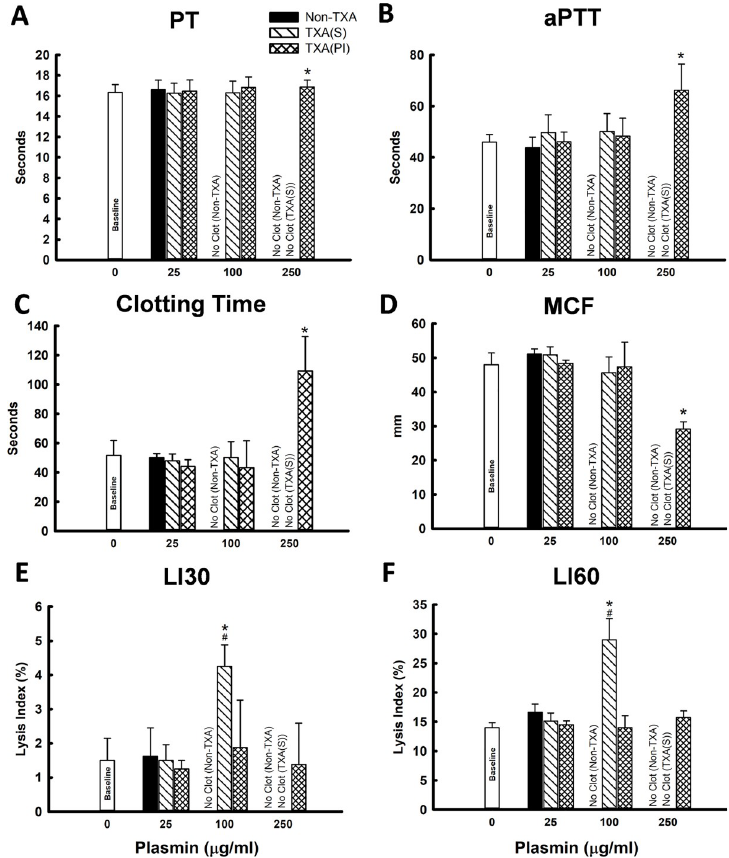
Fig 1. In-vitro assay in human whole blood (n = 4 per group). (A) PT; (B) aPTT; (C) Clotting Time (CT); (D) Maximum Clot Firmness (MCF); (E) Lysis Index at 30min (LI30, the percent reduction in MCF at 30min); (F) Lysis Index at 60min (LI60, the percent reduction in MCF at 60min). Non-TXA: plasmin was added alone when assay started; TXA-S: TXA and plasmin were added simultaneously when assay started; TXA-PI: TXA and plasmin were pre-incubated for 10min before assay started. Baseline: whole blood without treatment of TXA and plasmin. � : significant difference compared to baseline; #: significant difference compared to TXA-PI at given dose of plasmin. (“No Clot” was plotted in the graphs indicating one of following conditions: 1): PT or aPTT were beyond the range of assay (PT > 70 seconds; aPTT > 120 seconds); 2): CT were > 1000 seconds; 3): No reading on MCF and Lysis Index).